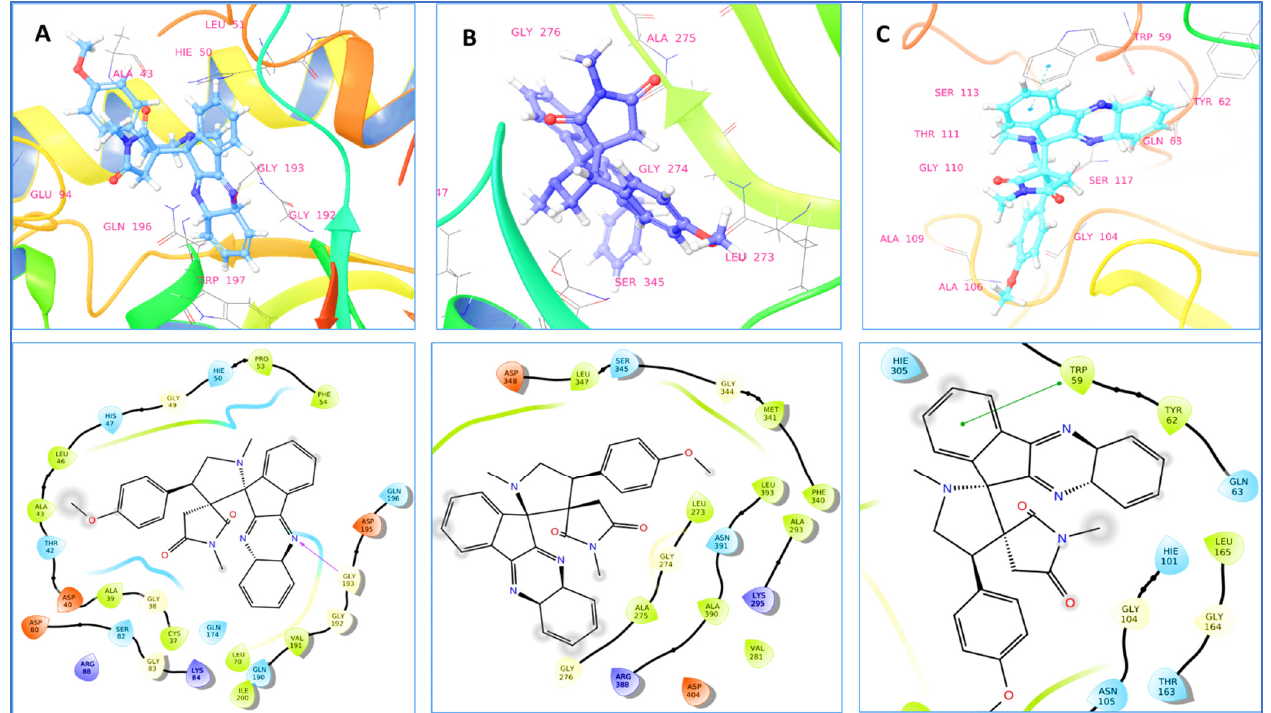
Figure 4. Binding interaction of promising compound 5d with ( A ) S. aureus tyrosyl-tRNA synthetase (PDB ID: 1JIJ); ( B ) Tyrosine kinase (PDB ID: 2HCK). ( C ) Human pancreatic α -amylase (PDB ID: 2QV4).